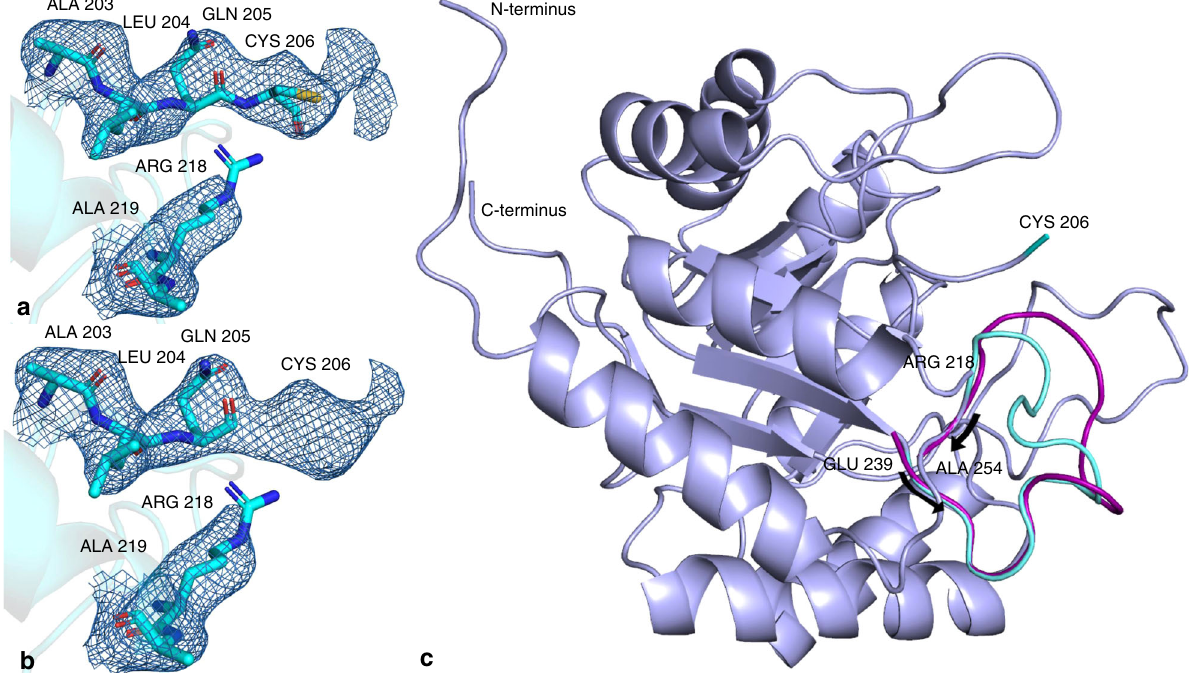
Fig. 4 Differences between our re fi ned model and the pdb entry 1X8F used as the search model. a and b 2Fo-Fc electron density map contoured at 1.0 σ in the unde fi ned loop region ranging from amino acids 206 through 218 missing in the search model 1X8F. Residual electron density can clearly be seen extending beyond GLN − 205 in b and a cysteine was built into position 206 and re fi ned ( a ). c Cartoon representation of the re fi ned model superimposed on PDB entry 1X8F. The different loop conformation (residue range 246-251) is highlighted in cyan (re fi ned model, deposited to the PDB accession code 6U57) and magenta (search model, PDB entry 1X8F). The diffraction patterns for 6U57 are available on the Coherent X-ray Imaging Data Bank (https:// cxidb.org) with entry ID